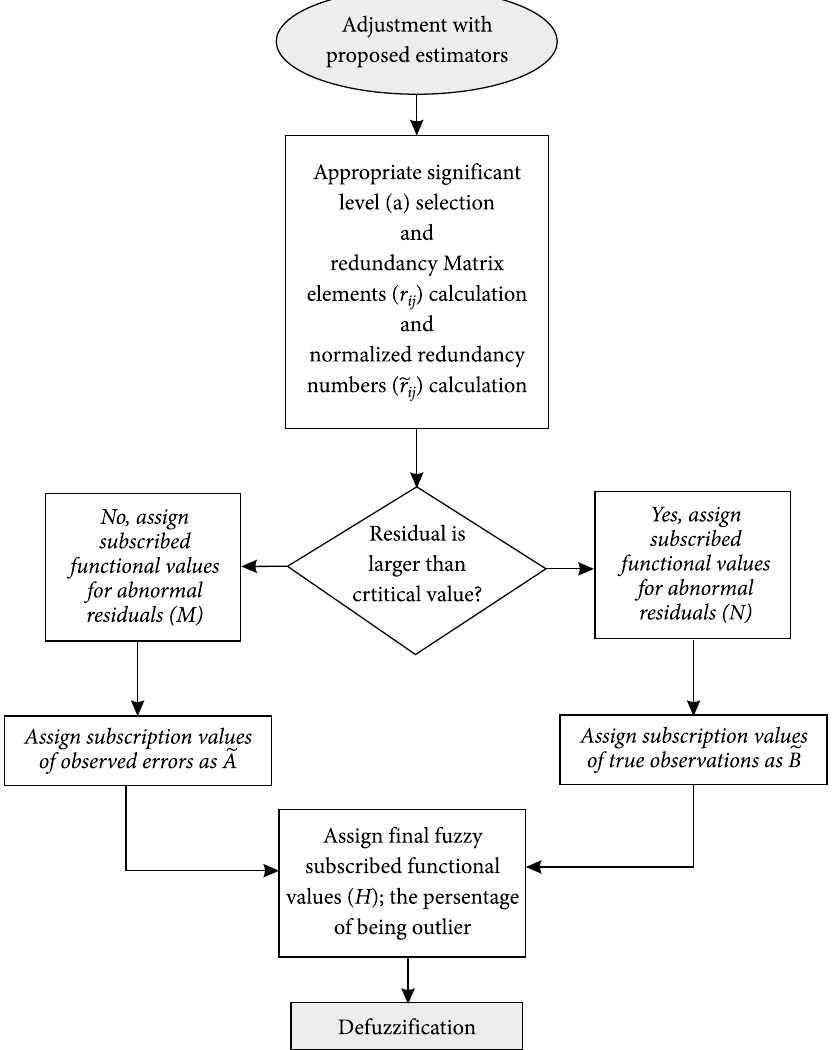
Fig. 1. Flowchart of proposed Fuzzy methodology in this